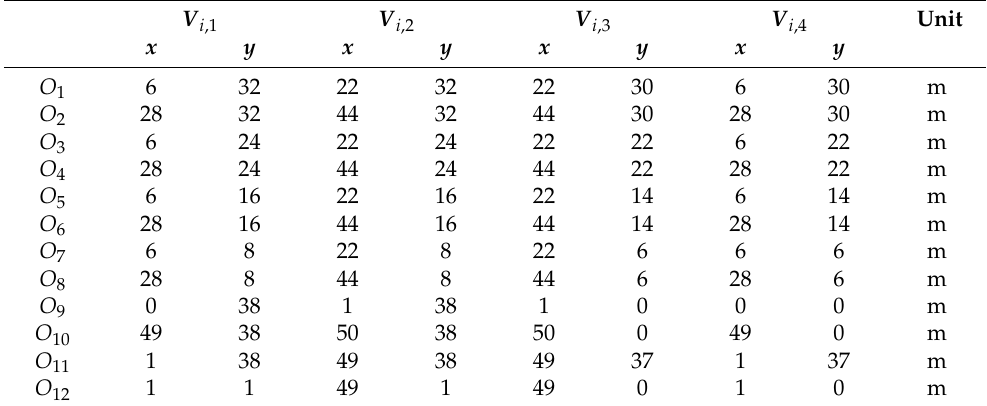
Table 1. Rectangular Obstacles